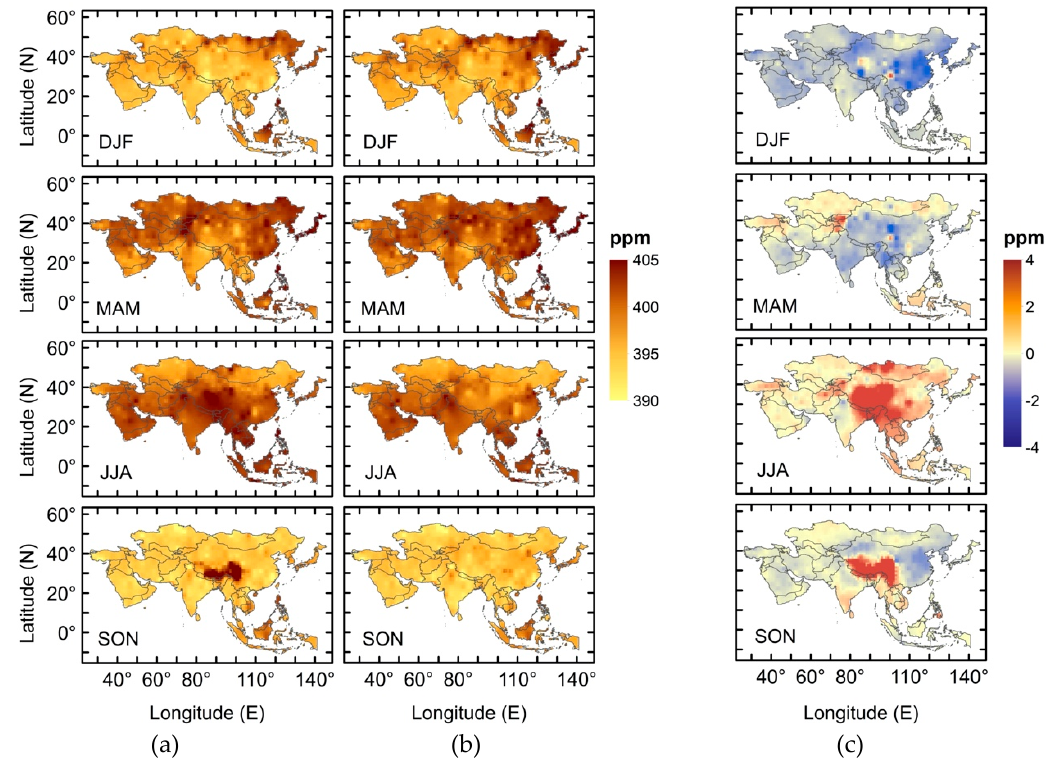
Figure 8. Seasonal distribution of XCO 2 from CT ( a ), GOSAT ( b ), and their differences (CT-GOSAT) ( c